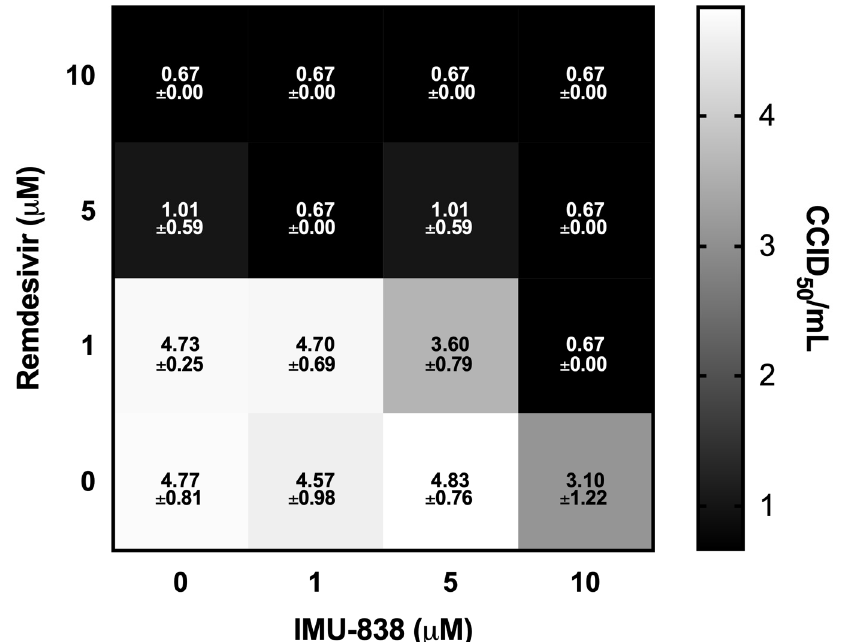
Figure 6. Combinatorial antiviral in vitro effect obtained through IMU-838 − RDV treatment of SARS-CoV-2-infected Vero cells. A viral yield reduction assay using a standard endpoint dilution assay and calculating the virus titer units at 50% cell culture infectious doses (CCID 50 ) per mL. Vero 76 cells were cultured for 3 days with DMSO control, 1, 5 or 10 µM IMU-838 or RDV either alone or in combination. Data represent mean values ± SD of determinations in triplicate ( n = 3). All squares showing a CCID 50 / mL of 0.67 were below the detection limit of 0.67. Table 2. Broadness of antiviral activity of vidofludimus analyzed for human cytomegalovirus (HCMV), hepatitis C virus (HCV), and human immunodeficiency virus type 1 (HIV-1). Virus